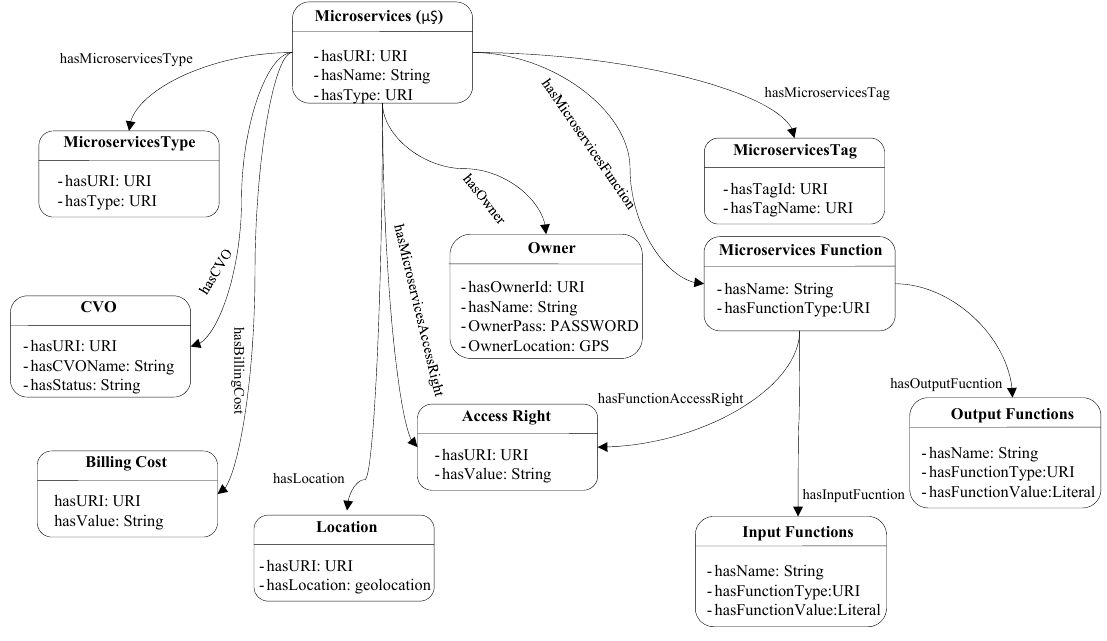
Figure 2. Information model for